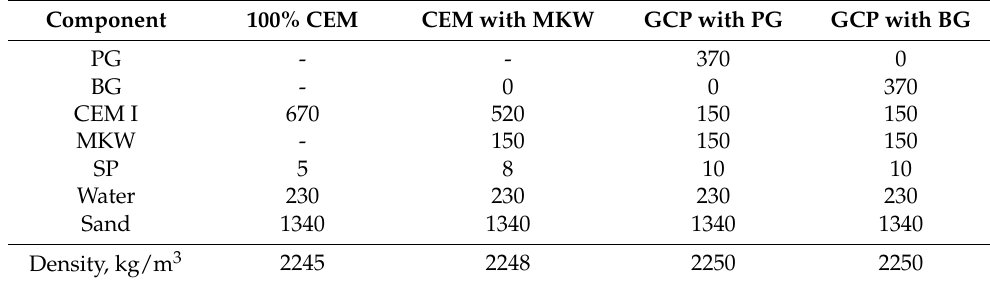
Table 1. Mixture compositions for 1m 3 of mortar with different types of binder, kg/m 3 .